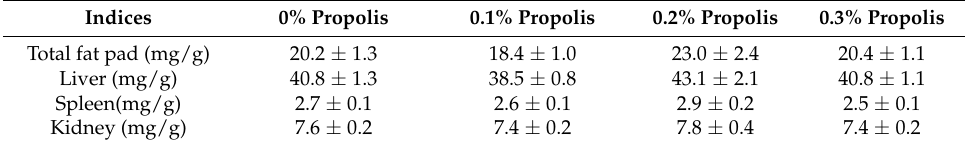
Table 2. Organ and fat pad weights 1 .